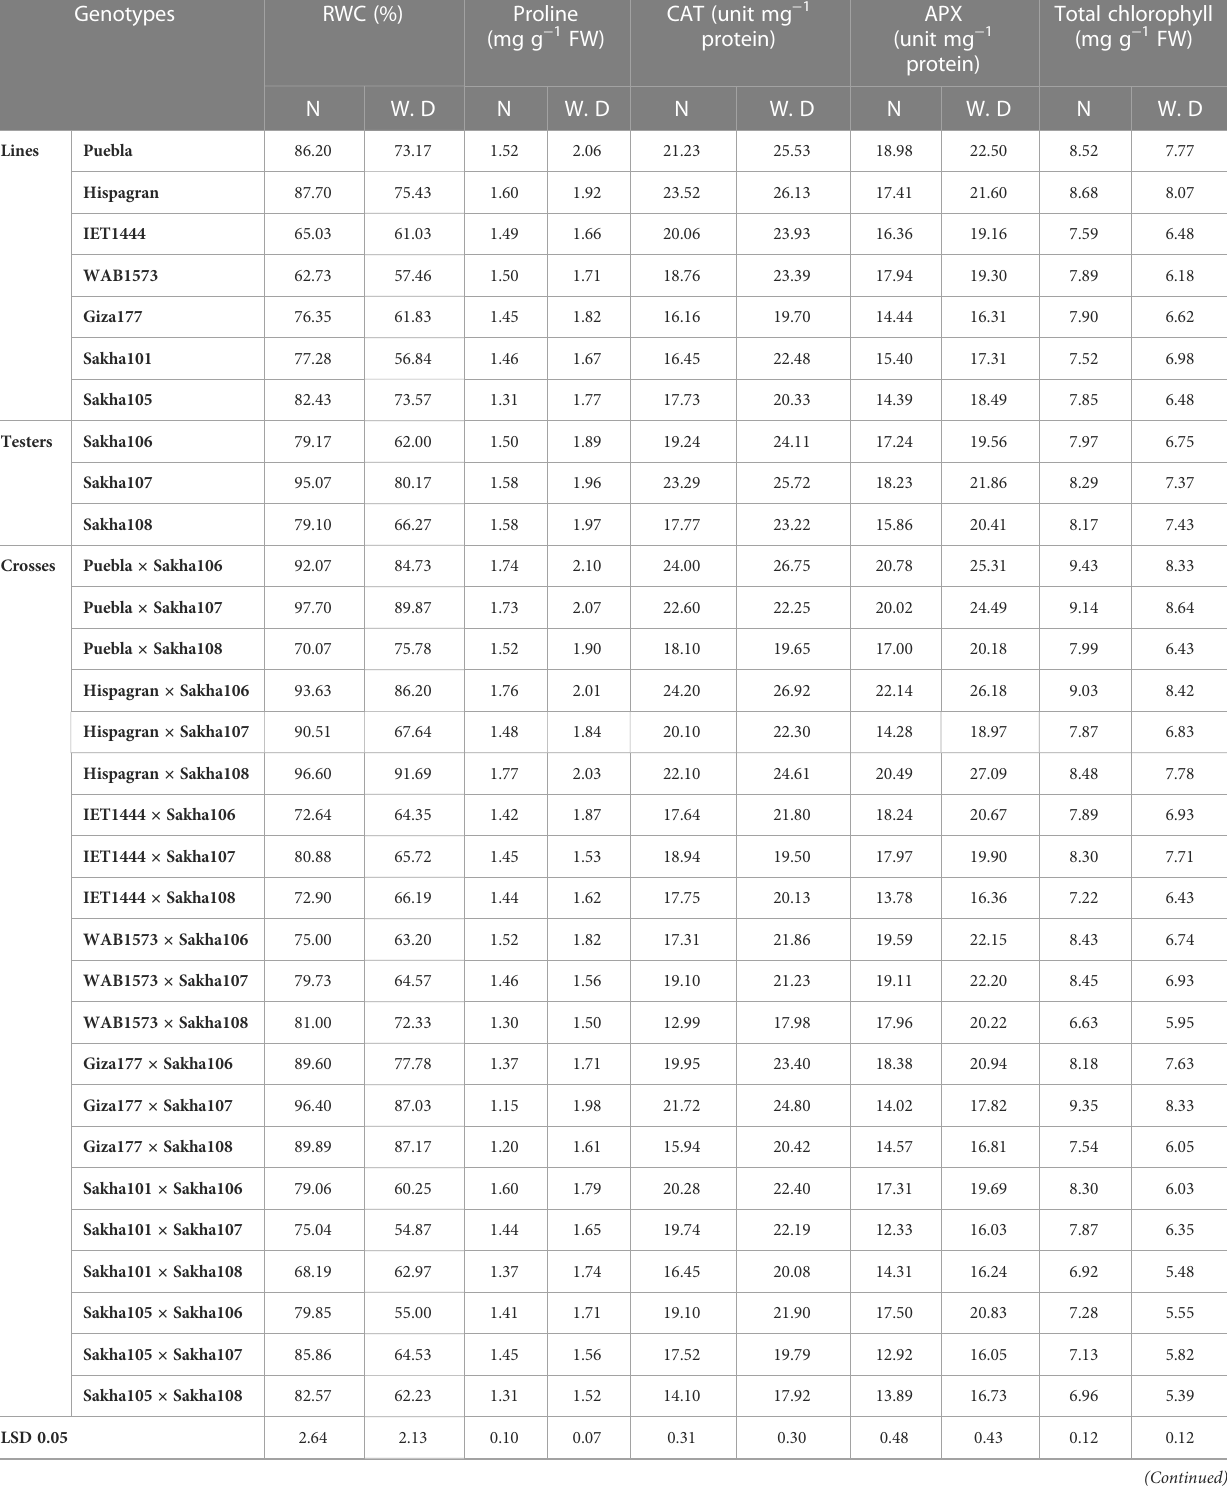
TABLE 3 Mean performance of lines, testers, and their F 1 crosses for physiological, biochemical, and yield-related (and its components) traits under normal watering and water de fi cit conditions.